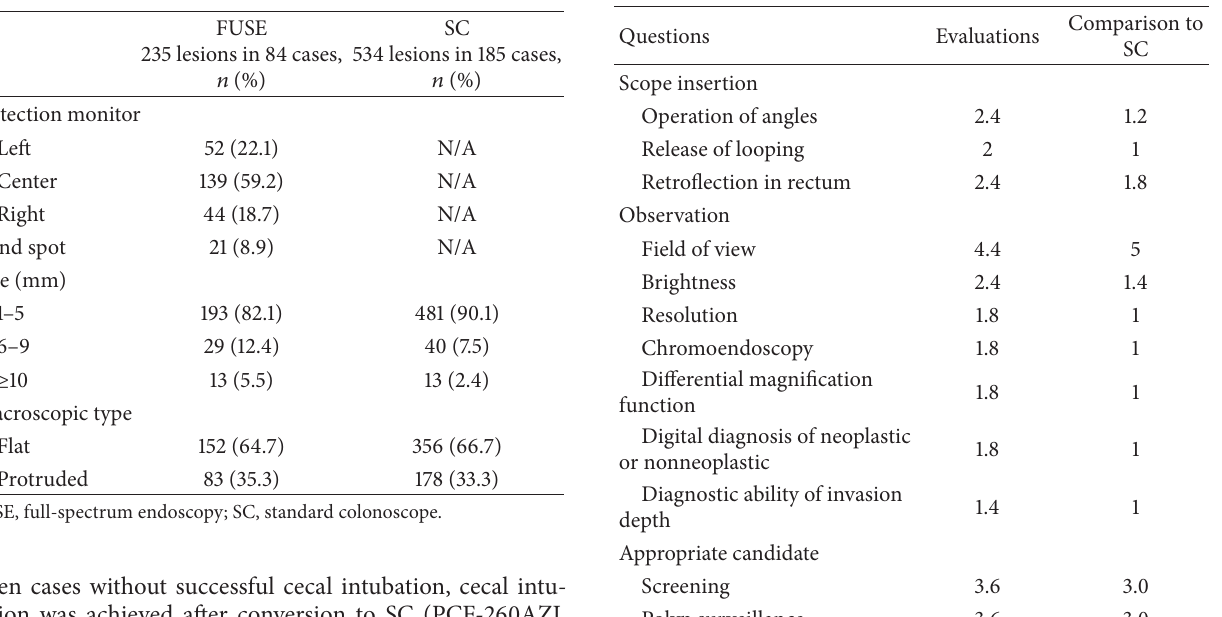
Table 2: Clinical characteristics of detected lesions by FUSE colon- oscopy and SC.